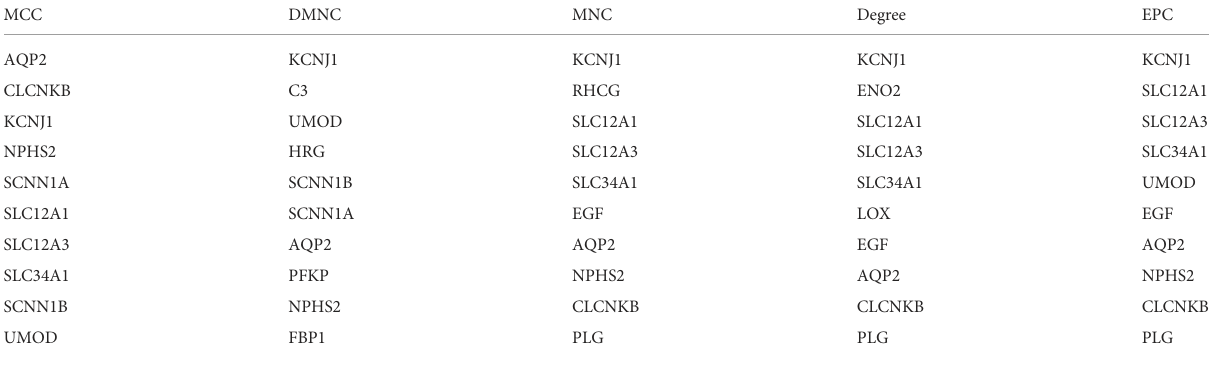
TABLE 2 DMNC, Degree, EPC, MCC, MNC top ten